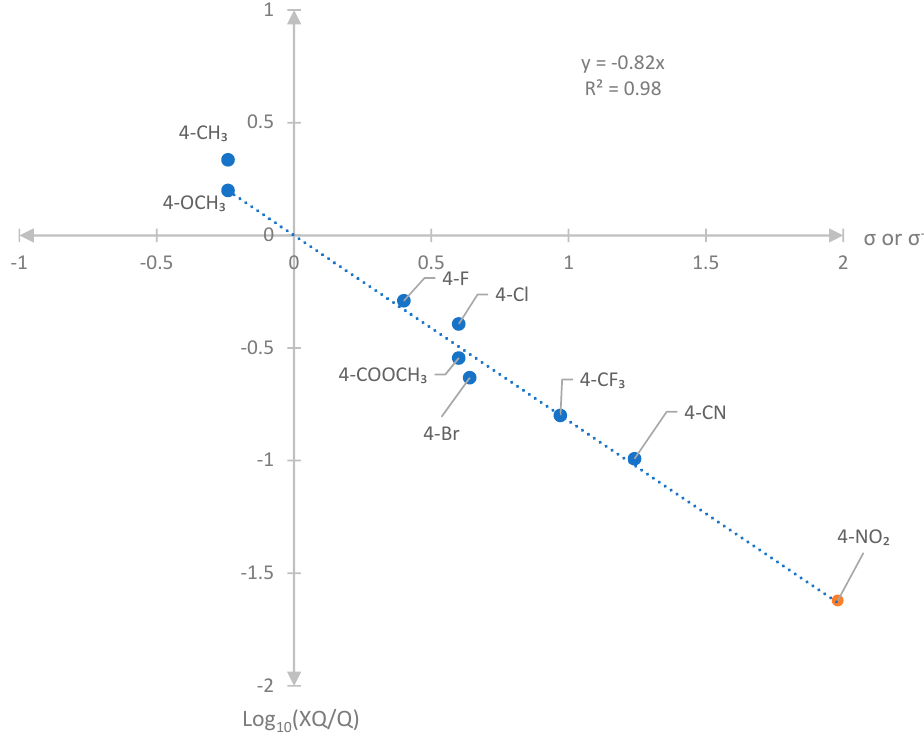
Figure 8. Hammett plot of XQ/Q ratio with standard composite σ constants except for X = NO 2 ( σ− constant, highlighted in orange).